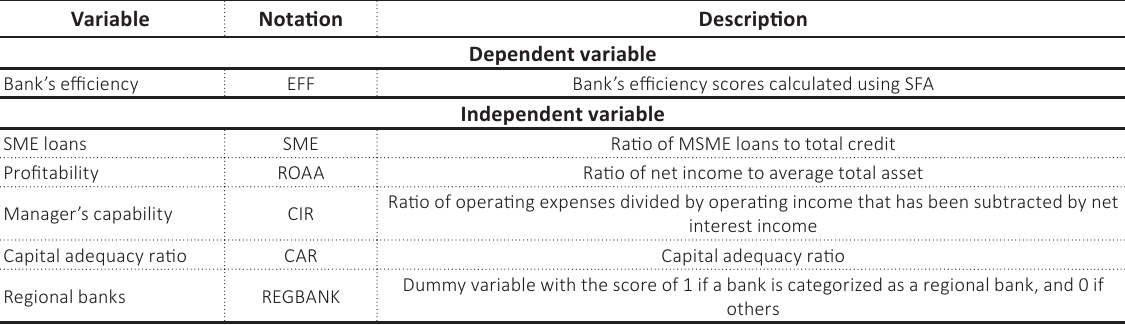
Table 3. Variable definitions and descriptions in the efficiency